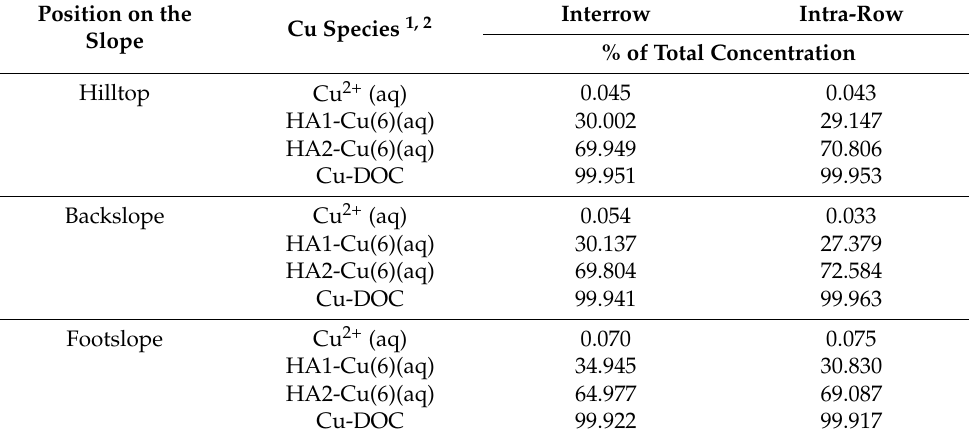
Table 4. Average distribution of copper species in leachates collected monthly for two years (2 Novem- ber 2020–25 November 2022) from lysimeters installed at the hilltop, backslope, and footslope of the vineyard inter- and intra-row, estimated using Visual MINTEQ chemical equilibrium software and NICA-Donnan model.